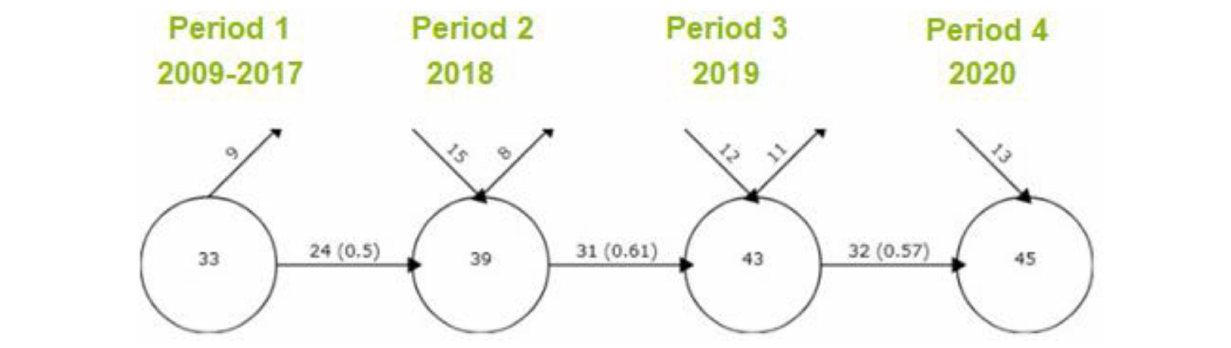
words were included in the research of the topic, totaling of 45 keywords. The difference between the number of keywords between the first and the last periods is relatively low but can be justified by the scarce research on the topic. These results